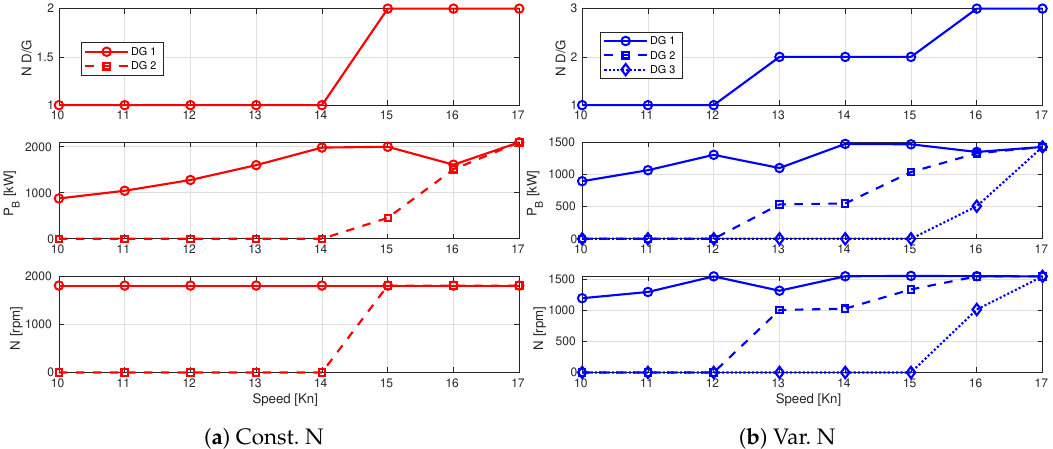
Figure 6. Off-design optimal propulsion configurations, constant ( a ) and variable revolution propulsion plant ( b ) with uneven optimal load